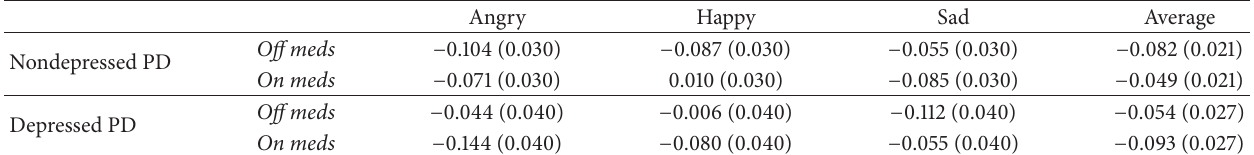
Table 2: VMPFC deactivation responses by group, medication status, and emotion category; values reflect the ROI marginal mean and standard error.